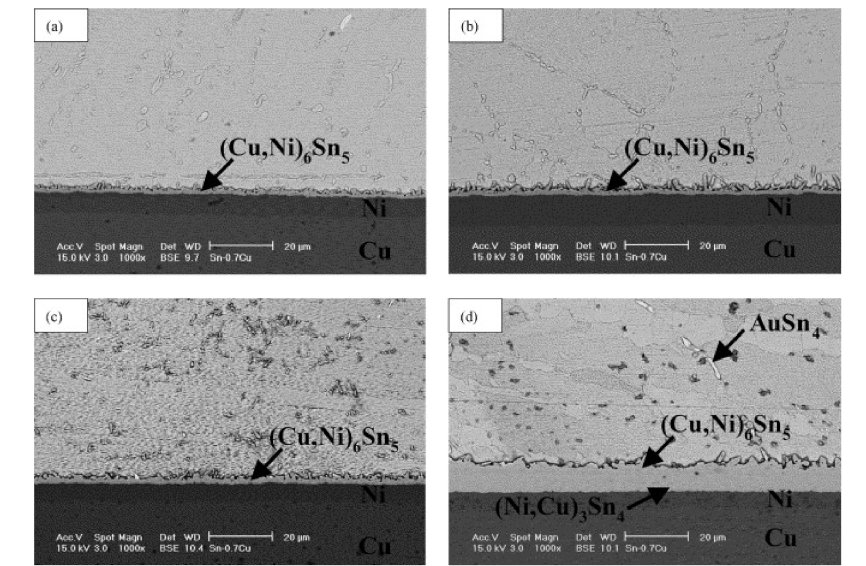
Figure 4. The Sn0.7Cu solder/Ni BGA SEM micrographs; Joints after aging for 100 days at a variety of temperatures: ( a ) 70 ◦ C, ( b ) 100 ◦ C, ( c ) 150 ◦ C, and ( d ) 170 ◦ C [85].